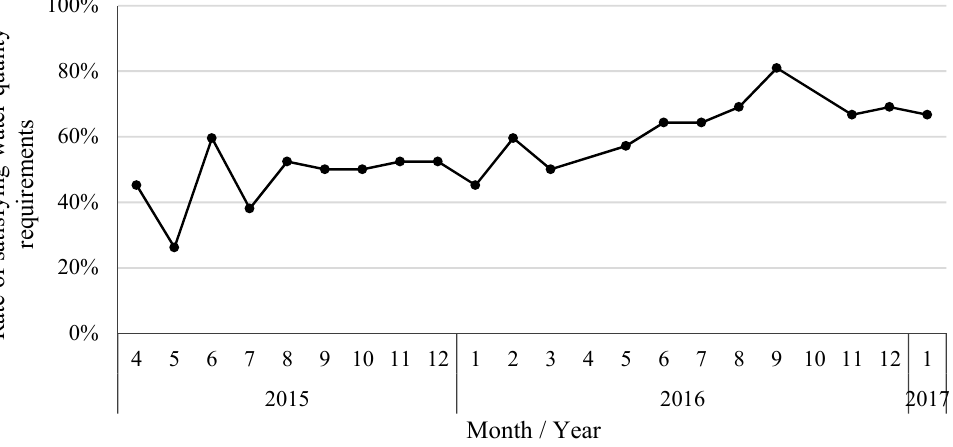
Figure 4. Rate of the first 42 rivers satisfying the Grade V requirements under charge of the river chiefs (Source: Official website of Foshan Environmental Protection Bureau).